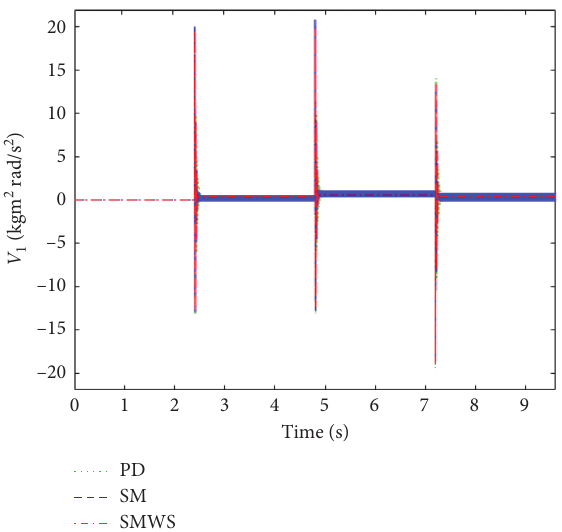
Figure 4: Fictitious input of the first electricity generator.